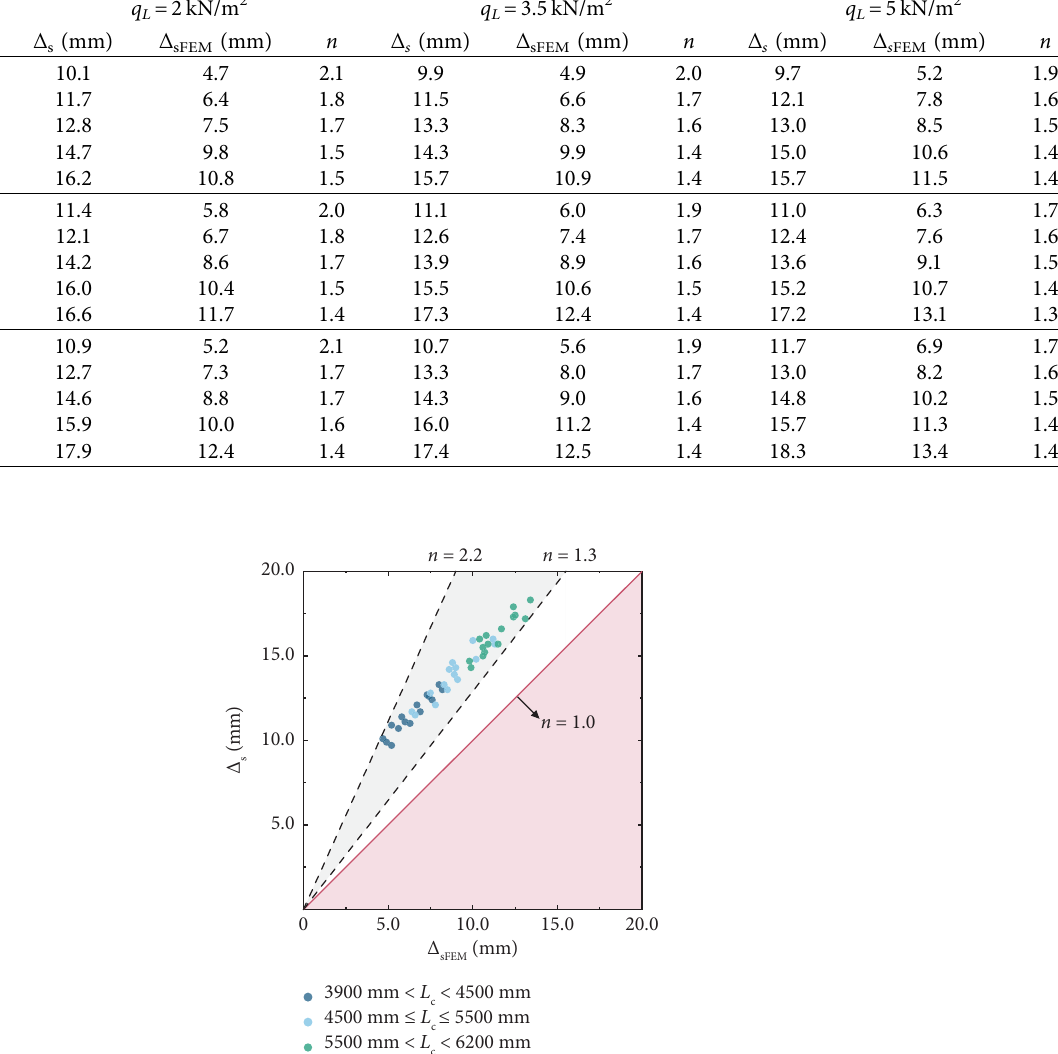
s ) and the simulation results